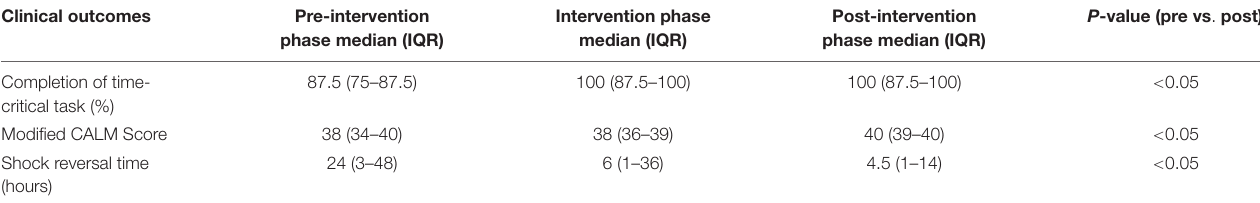
TABLE 3 | Clinical outcomes in patients with shock. Clinical outcomes Pre-intervention